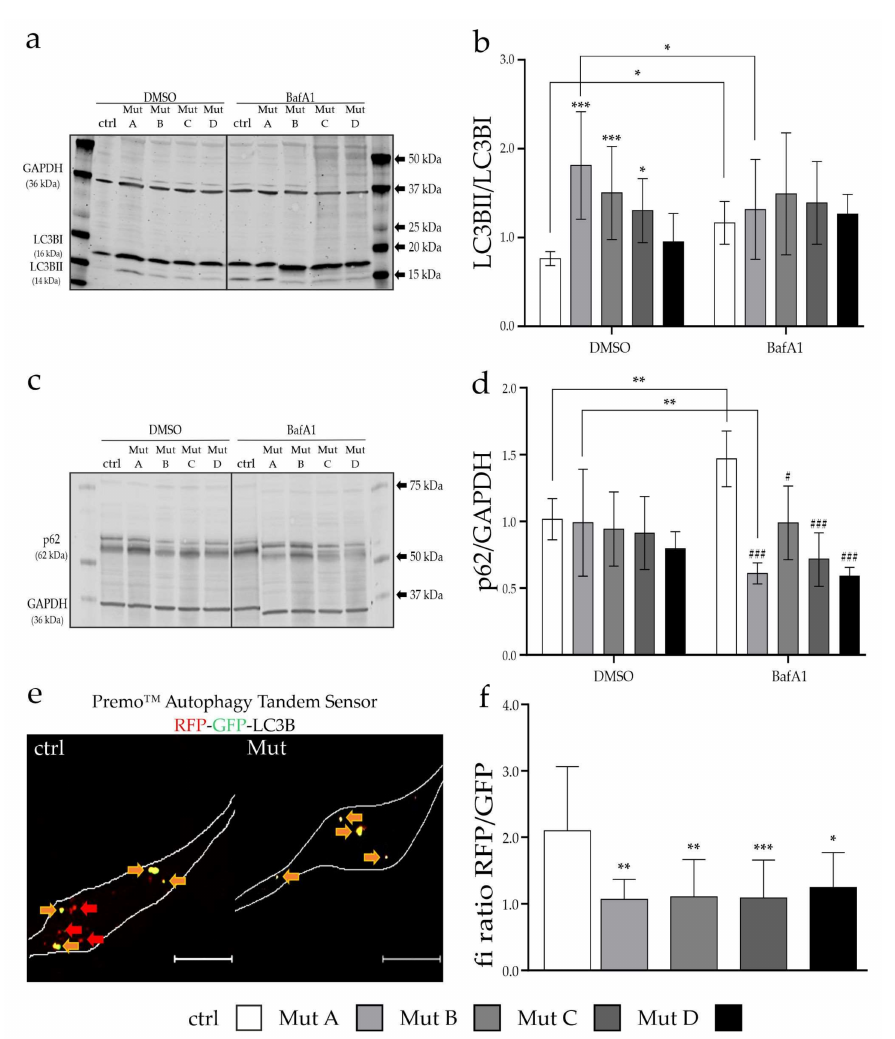
Figure 5. Analysis of the initiation and progression of the autophagic pathway. ( a ) Example Western blot for LC3B with the two isoforms LC3BI (16 kDa) and LC3BII (14kDa), without treatment (DMSO) and with treatment with bafilomycin A1 (BafA1). ( b ) Quantification of LC3BI and II with and without BafA1. Only the control cells showed an increase in the LC3BII/LC3BI ratio when blocking the clearance with BafA1. N = 4, n = 6–8. ( c ) Example Western blot of p62 (62 kDa) with and without BafA1 treatment. ( d ) Quantification of p62 showed that again only the control cell line was able to increase the p62 expression after BafA1 treatment. N = 4, n = 6–9. ( e ) Example picture of the control cell line transduced with the Premo™ Autophagy Tandem Sensor RFP-GFP-LC3B. Scalebar = 20 µ m. ( f ) Quantification of colocalization, based on the fluorescence intensity (fi) ratio of RFP/GFP, showed a reduced ratio in all NPC-deficient cells. Graphs show mean ± SD with * = p < 0.05, ** = p < 0.01, *** = p < 0.001 vs. untreated ctrl; and # = p < 0.05, ### = p < 0.001 vs. untreated of the same cell line. ctrl = control cell line. For ( b ) and ( d ), two-way ANOVA with Sidak’s multiple comparisons test was used; and for ( f ), one-way ANOVA with Dunnett’s multiple comparisons test was used to determine statistical significance. Statistical significance against the untreated control is indicated by (*), with * = p < 0.05, ** = p < 0.01, *** = p < 0.001; and against the treated control by (#), with # = p < 0.05, ### = p < 0.01. Mut A (NP-C1): c.1180T>C; Mut B (NP-C1): c.1836A>C/c.1628delC; Mut C